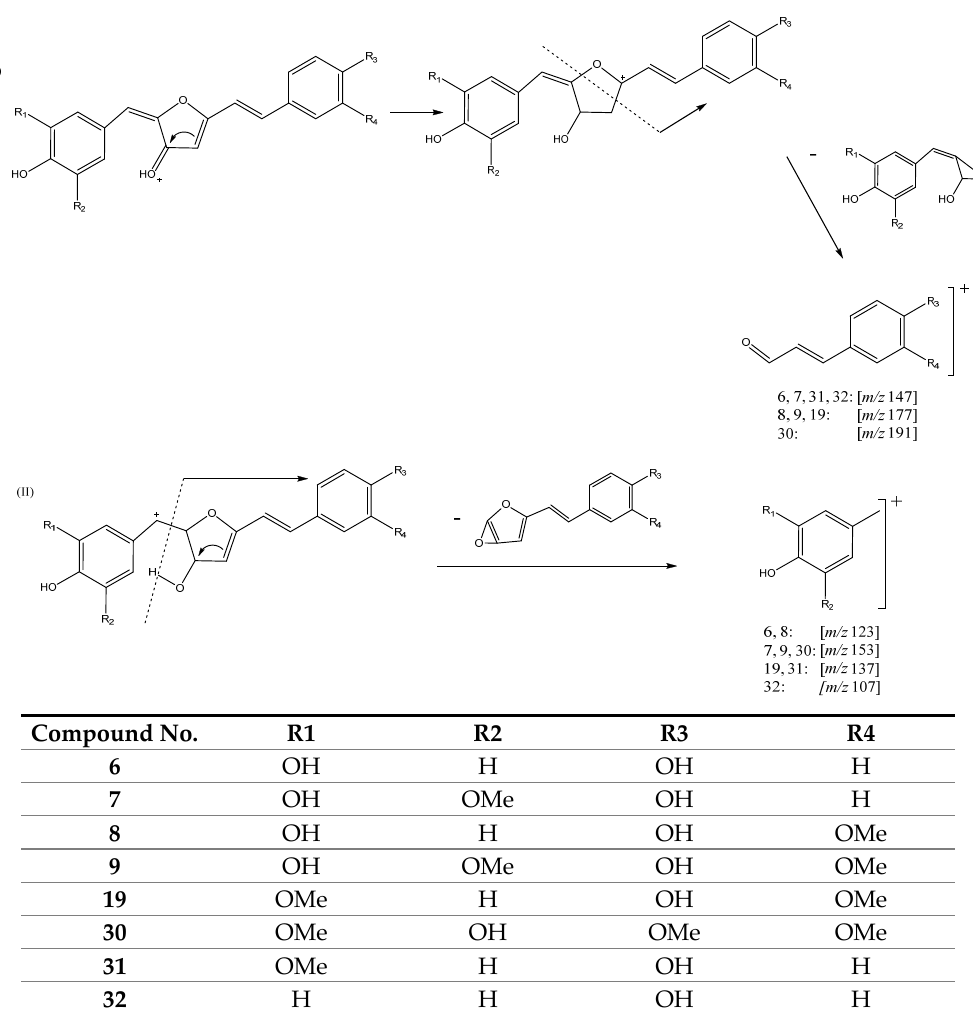
Figure 11. Fragmentation pathways I and II for compounds 3 and 5 .